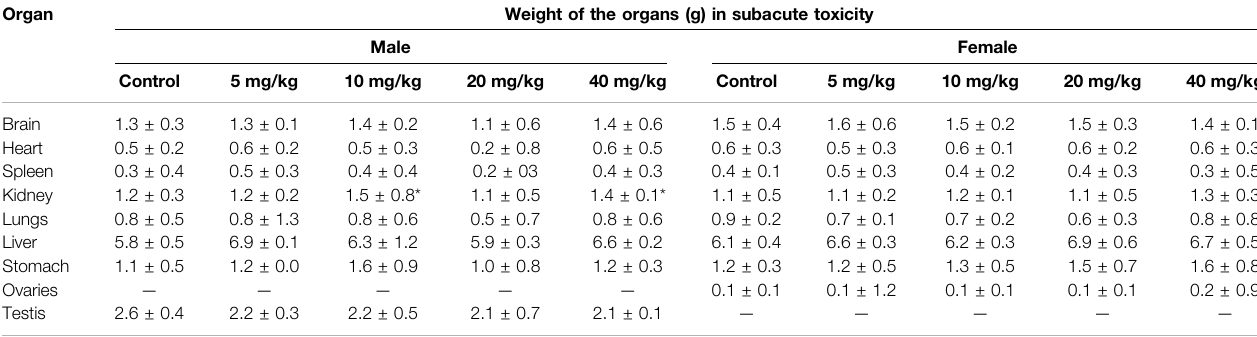
TABLE 4 | Effect of different doses of SF5 treatment on the organ weights of selected organs in the subacute toxicity study. Organ Weight of the organs (g) in subacute toxicity Male